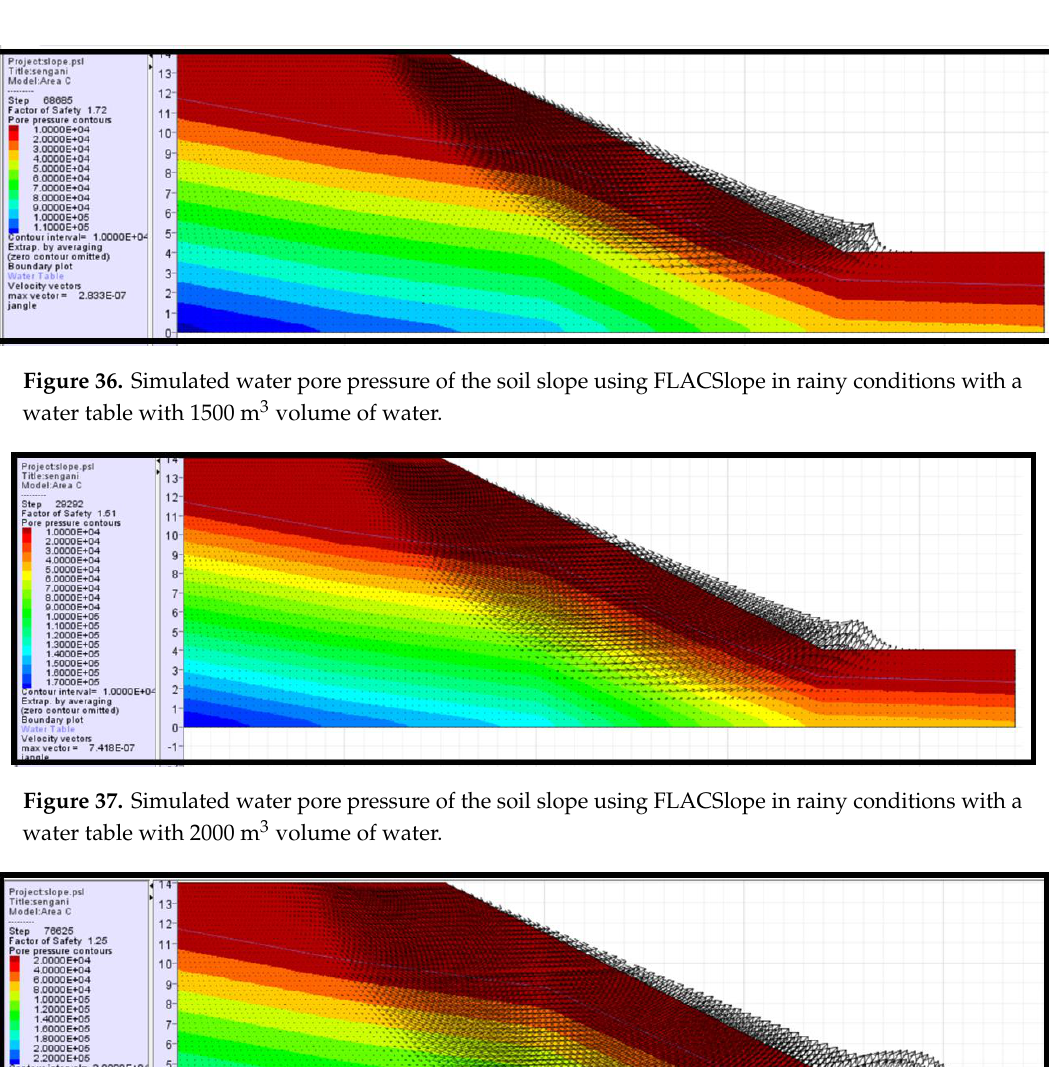
Figure 35. Simulated water pore pressure of the soil slope using FLACSlope in sunny conditions with a water table with 1000 m 3 volume of water.